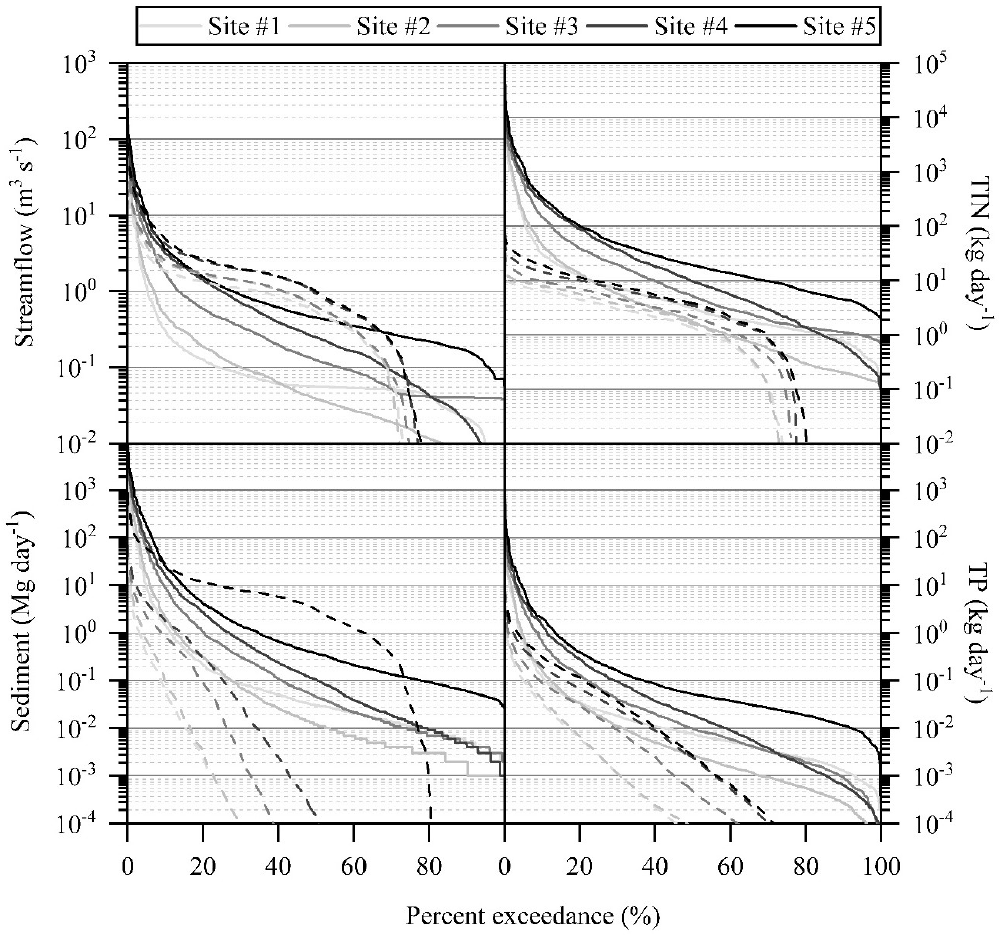
Figure 2. Simulated (dashed line) and observed (solid line) daily average flow and load duration curves at five gauging sites in Hinkson Creek, Missouri, USA. Total inorganic nitrogen is TIN, and total phosphorus is TP.